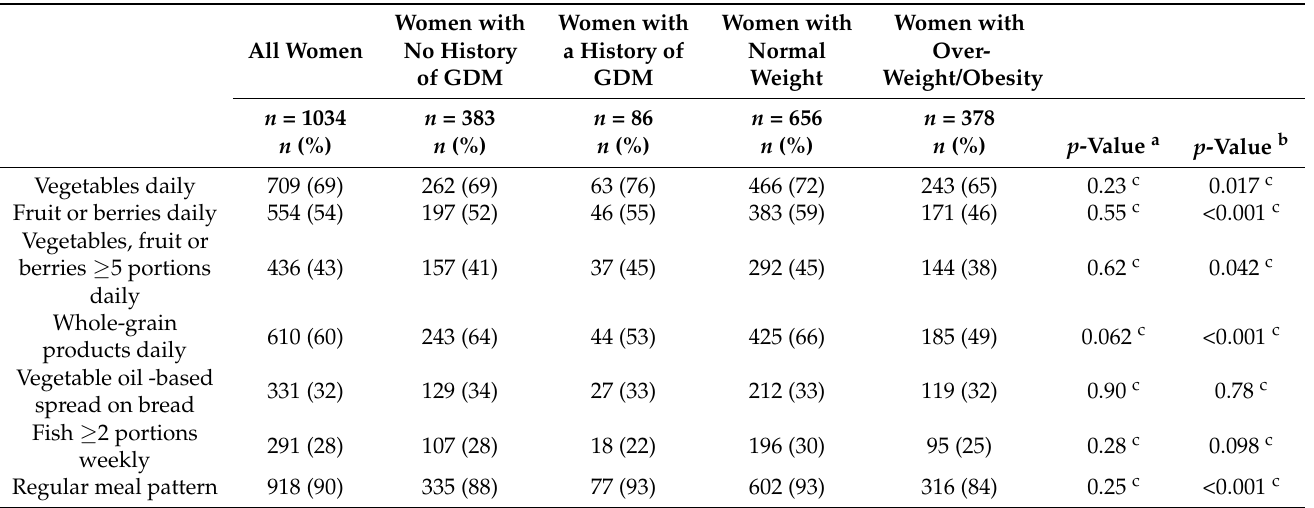
Table 3. Adherence to dietary recommendations in all the women, in the women without and those with a history of gestational diabetes and in the women with normal weight and women with